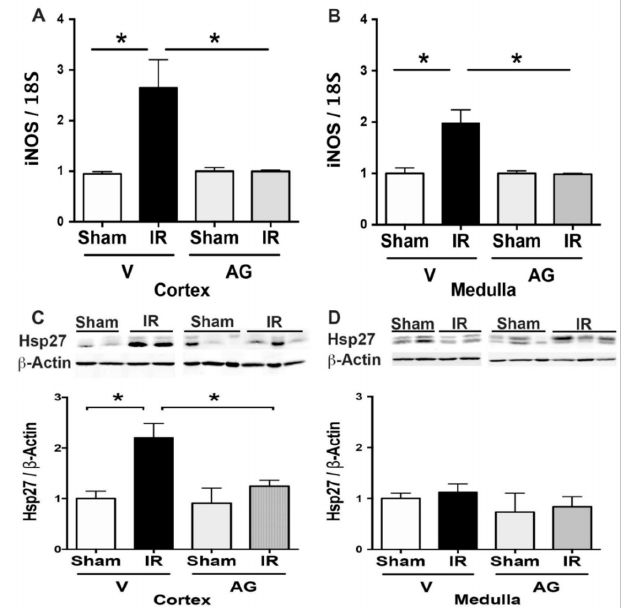
Figure 6. AG inhibited upregulation of iNOS and Hsp27 observed during IR. BALB/c mice were treated with AG (50 mg/kg i.p.) before sham or subjected to 30 min of ischemia and 48 h of reperfusion (IR). The iNOS mRNA expression was determined by qPCR and Hsp27 protein by Western blot in sham (n = 5), IR (n = 5), AG-sham (n = 6), and AG-IR (n = 6). ( A ) INOS mRNA in the cortex. ( B ) INOS mRNA in the medulla. ( C ) Hsp27 protein in the cortex. ( D ) Hsp27 protein in the medulla. The bar graph represents mean ± SEM, and the data were analyzed by using ANOVA and non-parametric Kruskal–Wallis test. * p < 0.05.